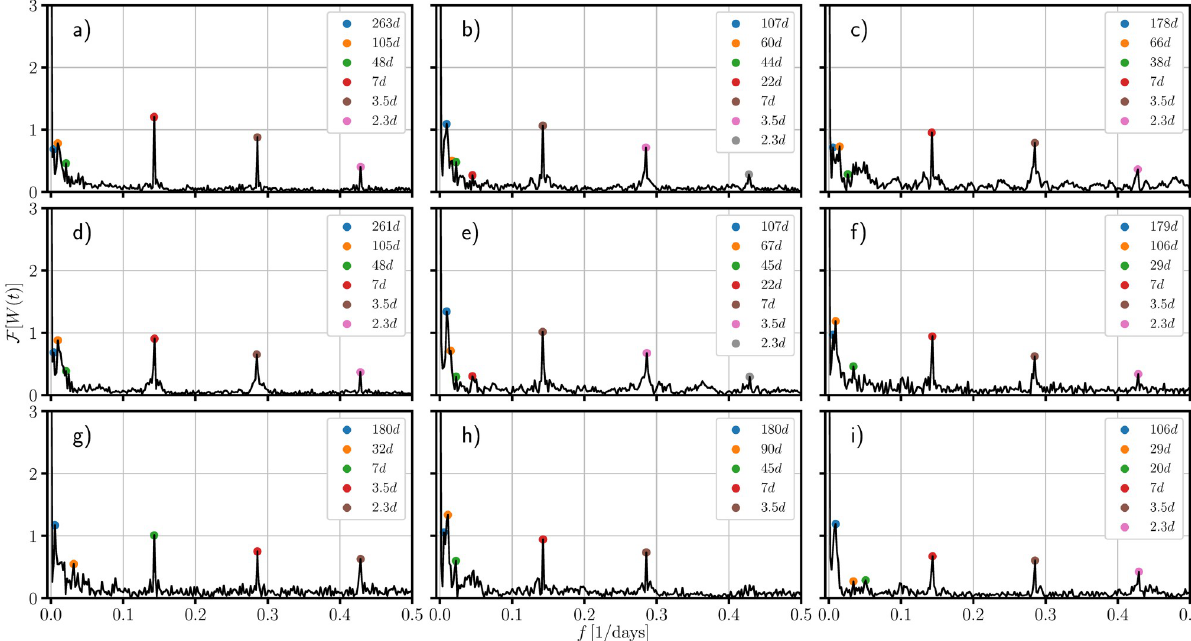
Fig 8. One-sided Fourier transform of the empirical weight function of some mexican federal entities. The figure shows the absolute value of the one-sided Fourier transform of the weight function derived from the empirical weight function of: a) Ciudad de Me´xico, b) Jalisco, c) Nuevo Leo´n,